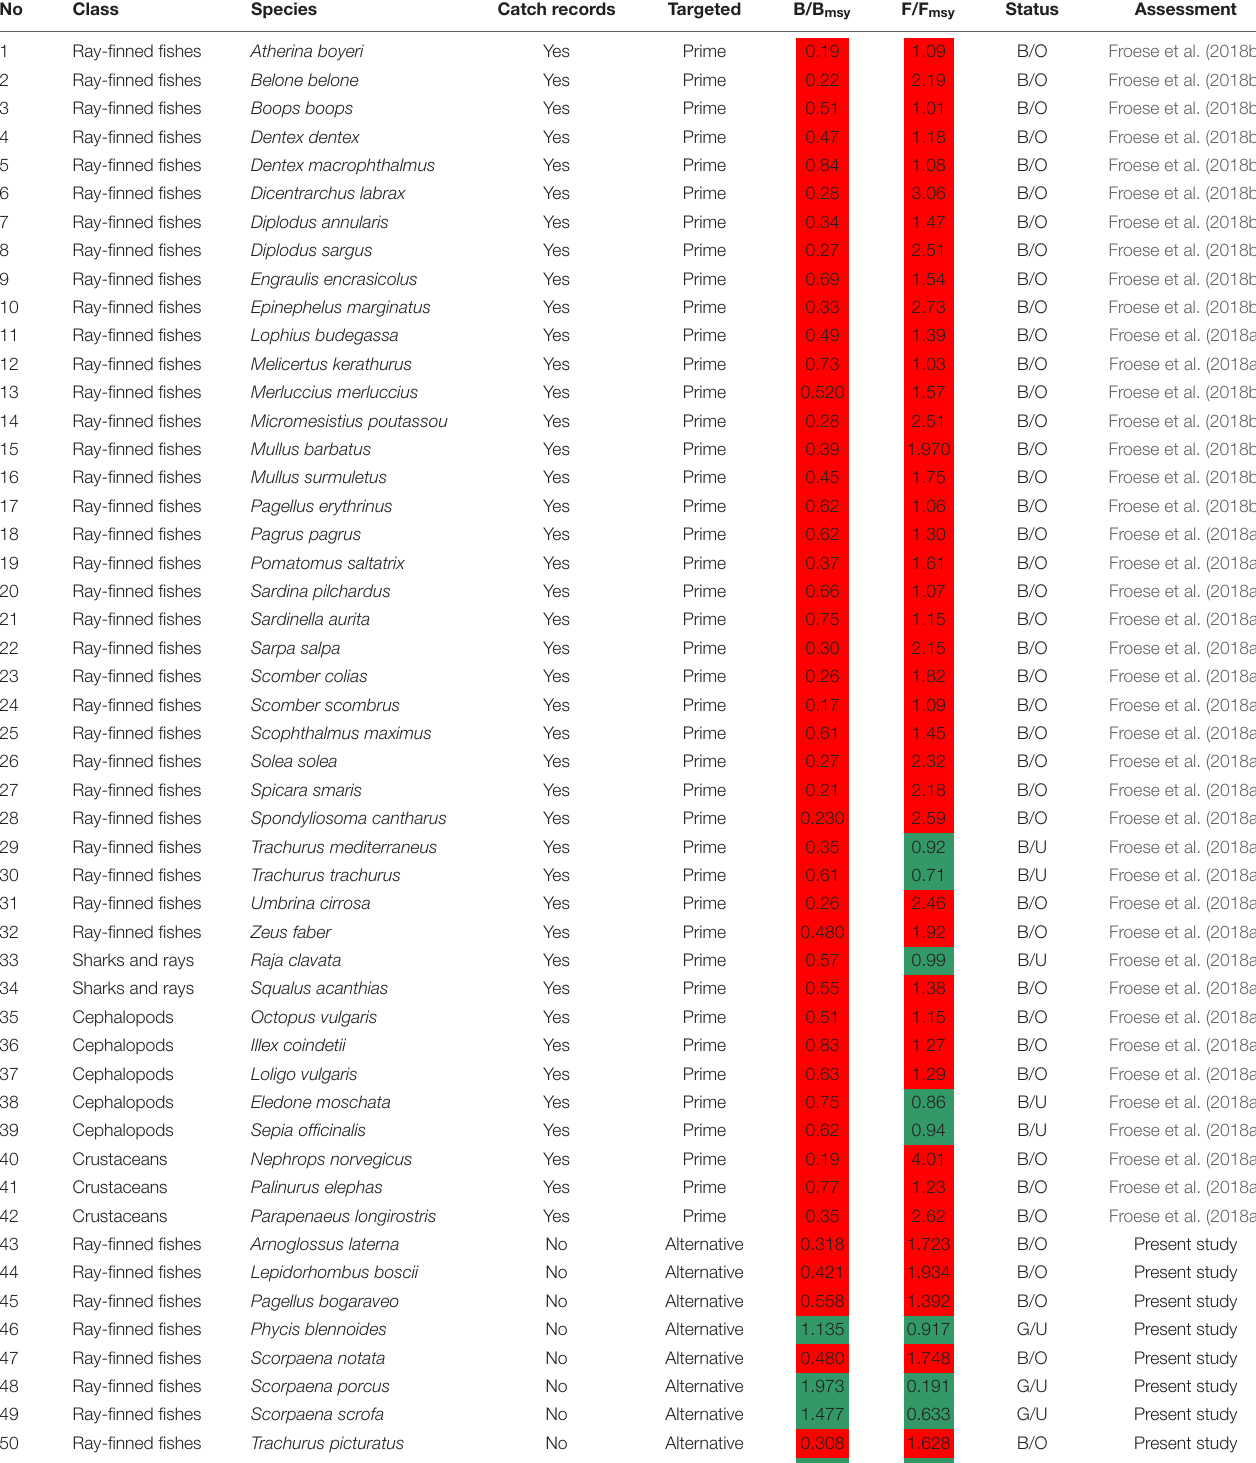
TABLE 1 | Analysis of 116 stocks in Aegean Sea with indication of existence of catch records, whether targeted (prime or alternative target), by-catch or discarded, biomass relative to the one that can produce the maximum sustainable yield (B/B msy ), fishing mortality relative to the one that can produce the maximum sustainable yield (F/F msy ), stock status and exploitation based on B/B msy and F/F msy and